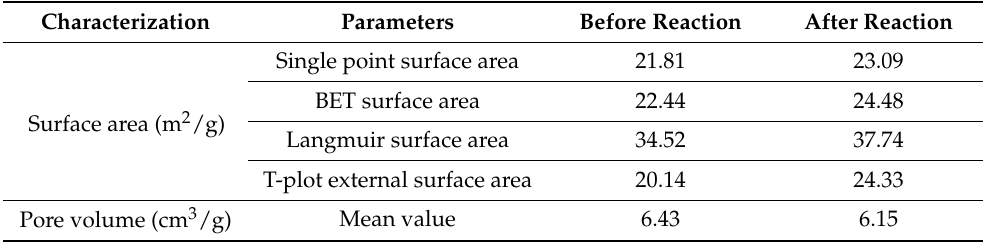
Table 4. Characterization parameters of sediment before and after MTA